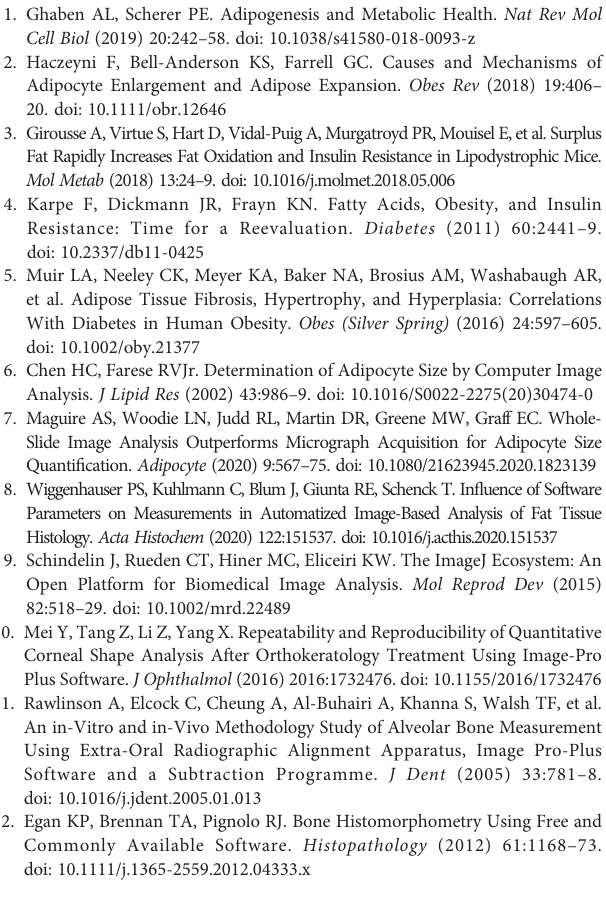
Supplementary Figure 1 | Two different segmentation images of AdipoCount. (A) Original image of adipocytes. (B) Preliminary segmentation image without correction. (C) Monochrome segmentation image after correction. (D) Color segmentation image after correction. Supplementary Figure 2 | The combined methods measured the size of very smalladipocyteaccurately. (A-D) Thesizedistributionsofadipocytes(rangeof240- 1000µm2, in 100 increments) measured by manual and combined methods, in eWAT of obese mice (A) , in iWAT of obese mice (B) , in eWAT of lean mice (C) , in iWAT of lean mice (D) IPP, Image-Pro Plus; AC, AdipoCount. Supplementary Figure 3 | UCP-1 immunostaining of iWAT in lean